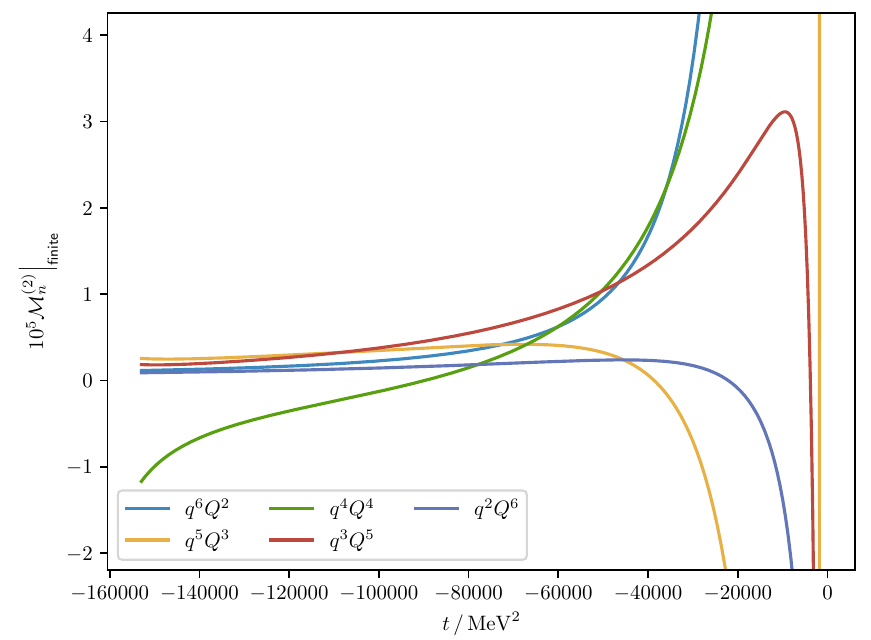
Figure 2 . The finite part of the matrix element M (2) n ( m = 0) , defined in (2.4), calculated in the fdh scheme, within the kinematic region used in section 3, i.e. s = 174 684 MeV 2 and t ∈ [ − 153 069 , − 1 021] MeV 2